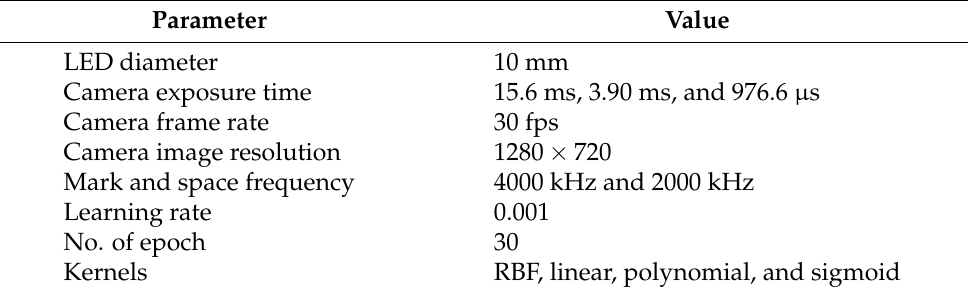
Table 2. Parameters used in the implementation of the proposed